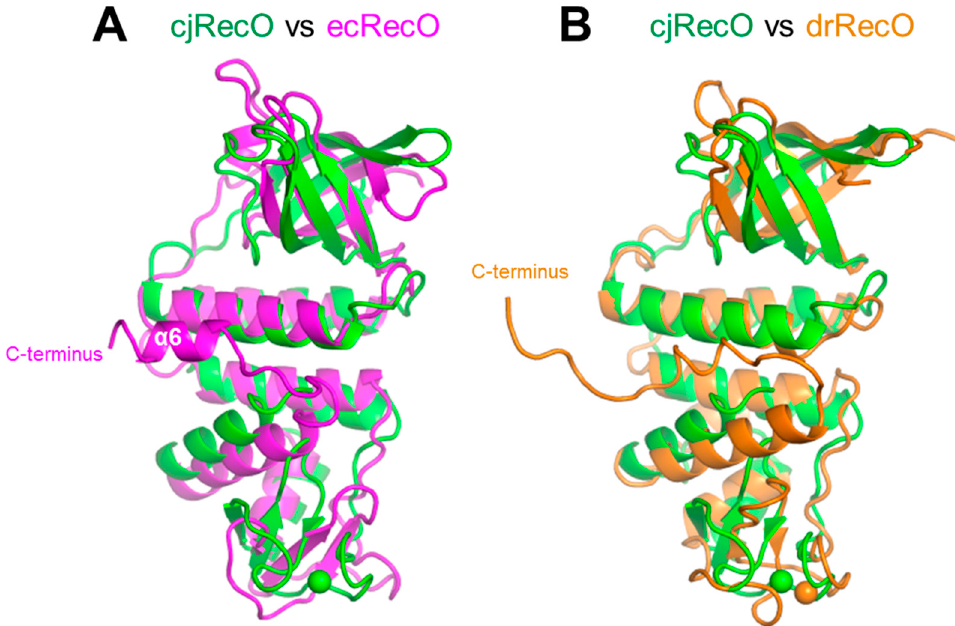
Figure 2. Structural comparison of cjRecO with ecRecO and drRecO. ( A ) Overlay of the cjRecO (green ribbons) and ecRecO (magenta ribbons; PDB ID 3Q8D) structures. A Zn 2+ ion in the cjRecO structure is depicted as a green sphere. The orientation of cjRecO is identical to that shown in the right side of Figure 1A. ( B ) Overlay of the cjRecO (green ribbons) and drRecO (orange ribbons; PDB ID 1U5K) structures. Zn 2+ ions in the cjRecO and drRecO structures are depicted as green and orange spheres, respectively. The orientation of cjRecO is identical to that shown in the right side of Figure 1A.